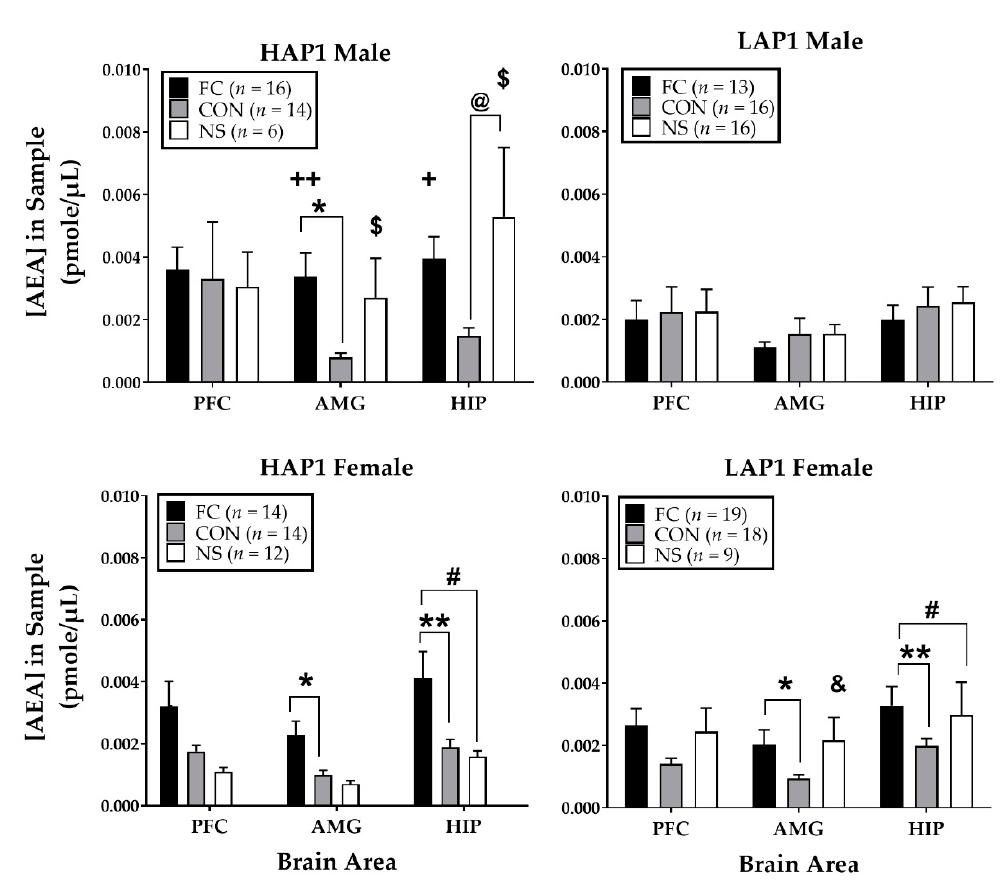
Figure 2. Mean ( ± SEM) concentration of AEA (the endocannabinoids, anandamide) in the prefrontal cortex (PFC), amygdala (AMG), and hippocampus (HIP) immediately after the FPS test in HAP1 (left panels) and LAP1 (right panels) male and female mice in the fear-conditioned (FC; paired light + shock), control (CON; unpaired light and shock) and no-shock (NS; light only) groups for experiment 1. + p = 0.05, ++ p = 0.01 FC males HAP1 > LAP1; * p < 0.05, ** p < 0.01 FC > CON (collapsed across line in females only); # p < 0.05, females FC > NS (collapsed across line); male HAP1 @ p < 0.05, NS > CON; & p < 0.05, NS females LAP1 > HAP1; $ p < 0.05, NS HAP1 males > females.